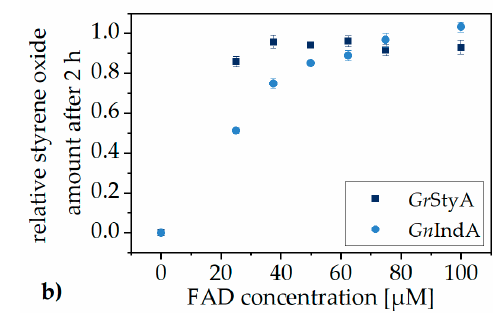
Figure 2. Relative produced styrene oxide amount under standard reaction conditions (20 mM Tris-HCl pH 7.5, 1 mM dithiothreitol, 5 vol.% glycerol, 20 U/mL catalase and 10 vol.% MeOH for Gn IndA or 5 vol.% DMSO for Gr StyA) in variation of ( a ) BNAH (50 µM FAD added) and ( b ) FAD concentration (10 mM BNAH added) for Gr StyA and Gn IndA: Both enzymes show their maximal product amount for a supplied BNAH concentration of 10 to 15 mM in presence of 50 µM FAD. The cofactor concentration to reach >90% relative product amount was determined for Gr StyA >40 µM and for Gn IndA > 60 µM FAD.